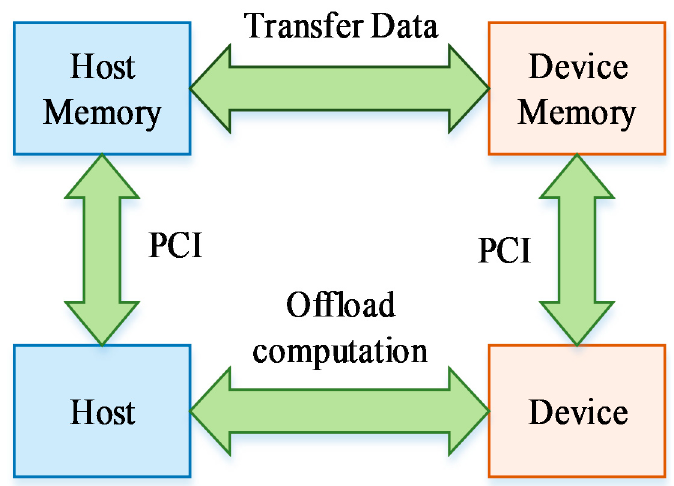
Figure 2. Open accelerator (OpenACC) model [38].